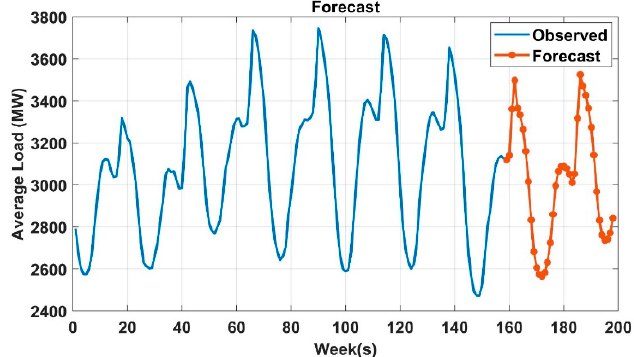
Figure 19. Training progress representation for per-week forecasting using LSTM-based DNN.